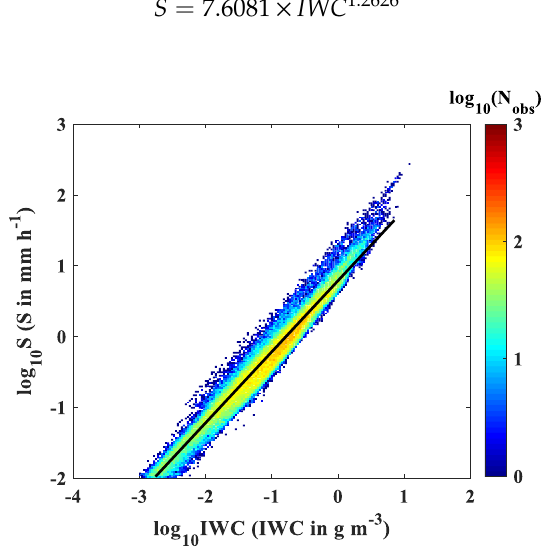
6 of 15 6 of 15